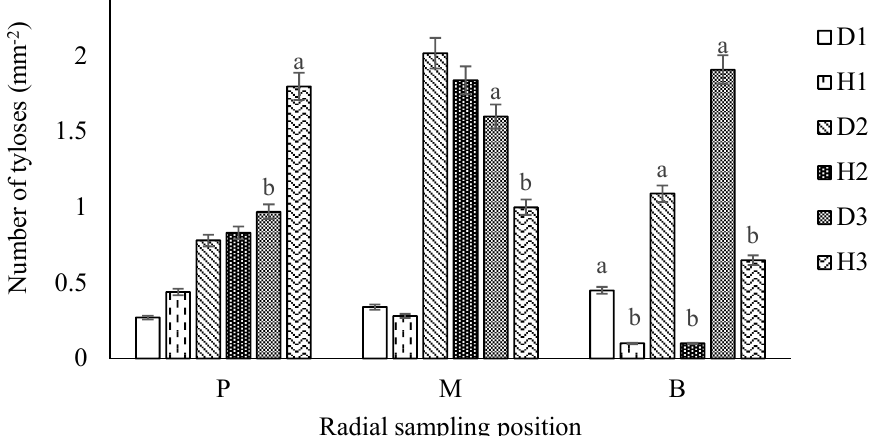
Figure 7. Mean number of tyloses in xylem vessels of Quercus brantii. H: Healthy trees; D: Declined trees; 1: Area A; 2: Area B; 3: Area C; P: Near-pith; M: Middle; B: Near-bark. The bar on each column represents the SE (standard error). Columns with no letters on them indicate insignificance.